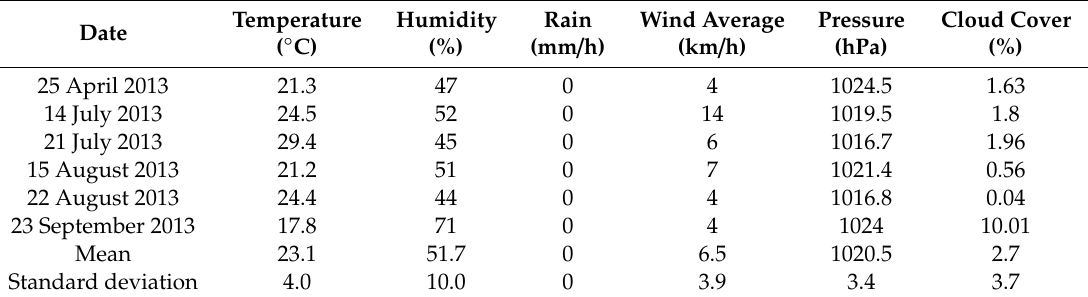
Table 2. Meteorological parameters of study days at the Lyon-Bron station at 12:00 p.m. (data: Météo-France [30]).